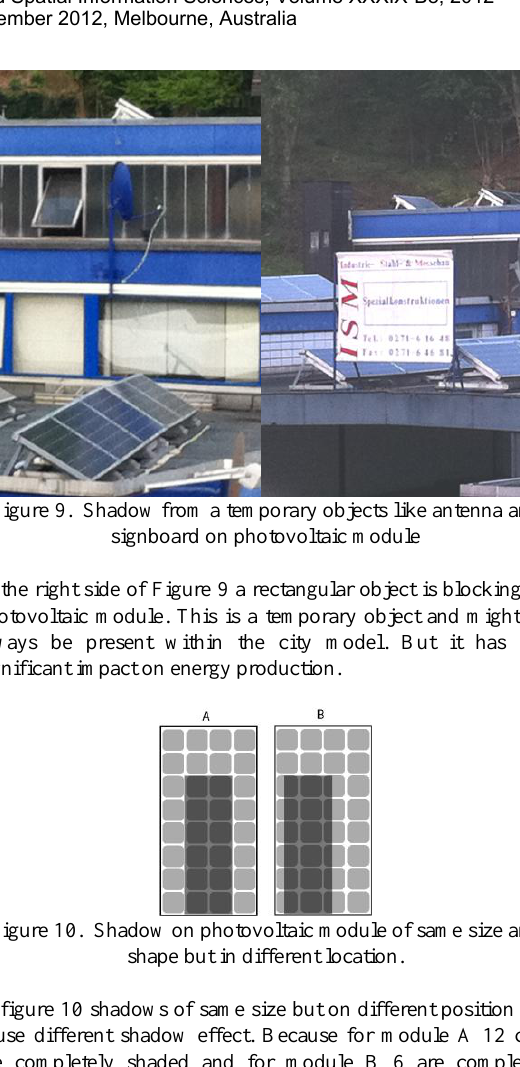
Figure 7. Shadow area in the morning